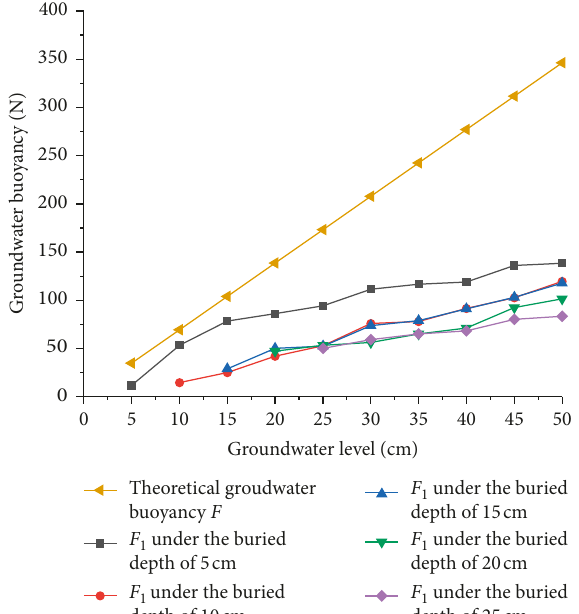
Figure 4: Variation of experimental groundwater buoyancy with the groundwater level under different buried